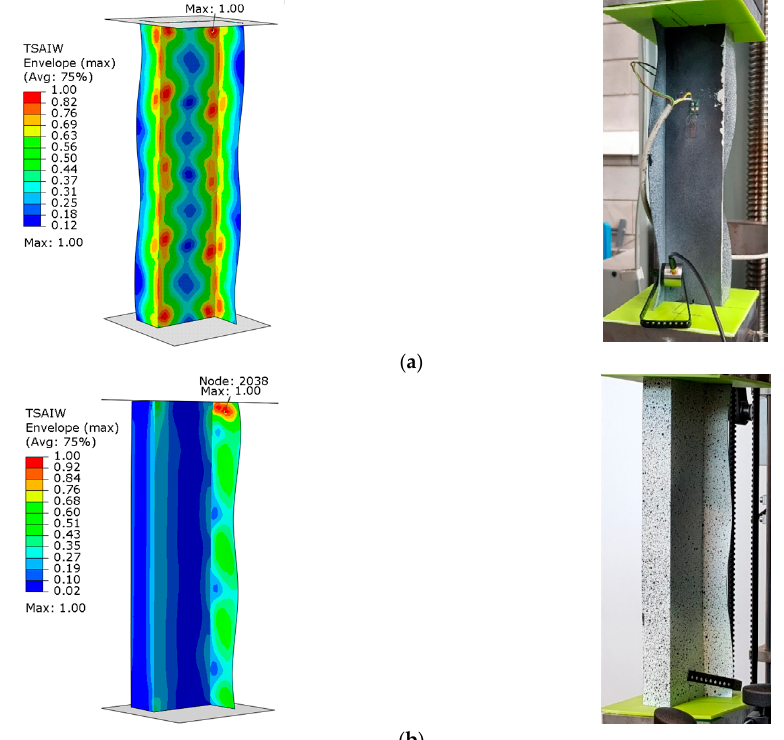
Figure 13. Column z_3—maps of the Tsai–Wu critical parameter and forms of post-critical deformation: ( a ) Test 1 and ( b ) Test 3.